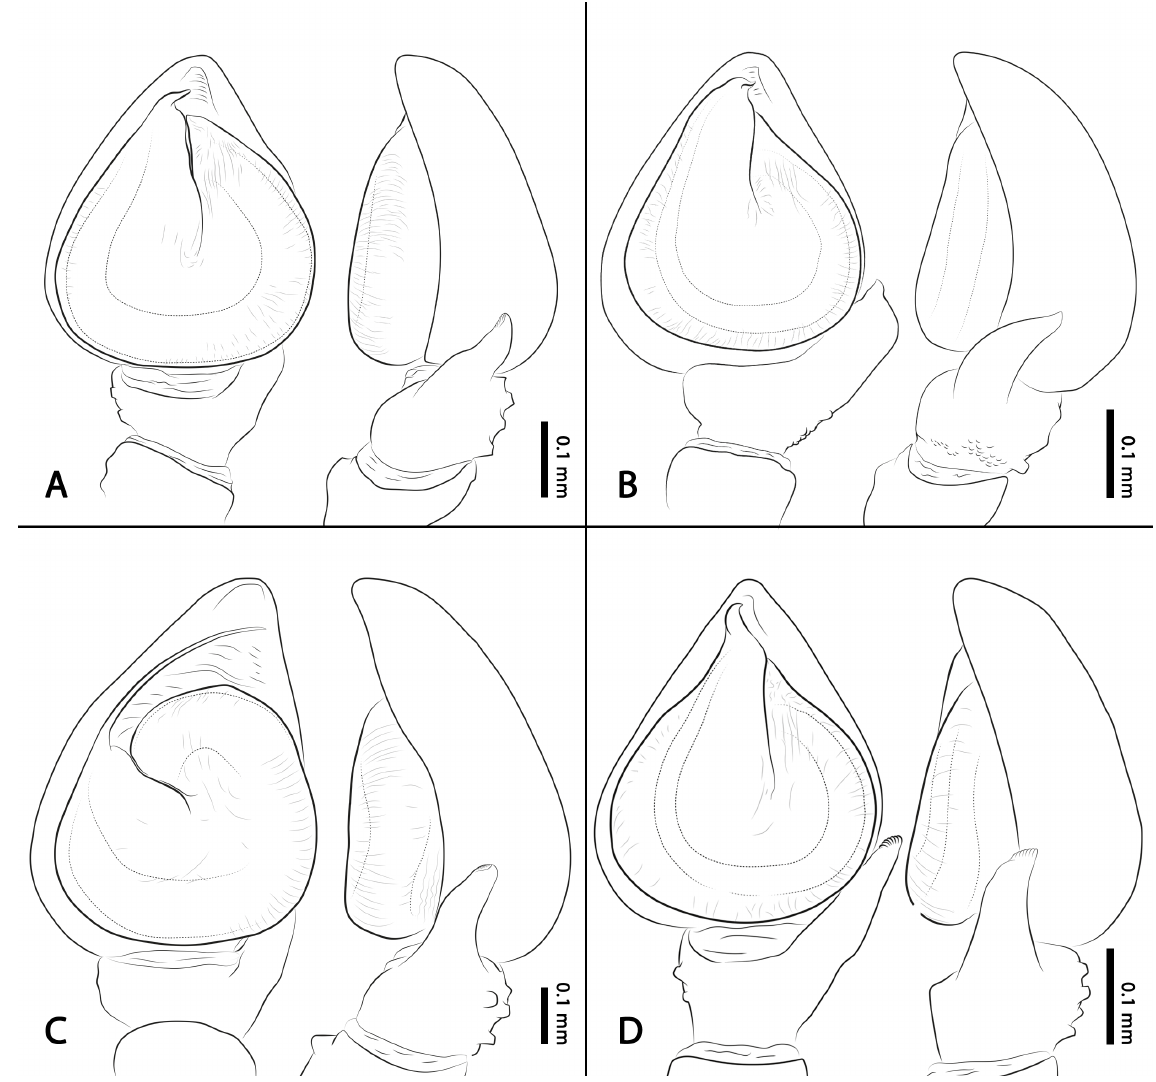
Fig. 20. Illustrations of the left male palp in ventral and retrolateral view. A . Kryptochroma septata Machado & Teixeira gen. et sp. nov., paratype (UFMG 22431). B . K. hilaris Machado & Teixeira gen. et sp. nov. (MPEG 13239). C . K. macrostyla (Mello-Leitão, 1929) gen. et comb. nov. (MZSP 15320). D . K. parahybana (Mello-Leitão, 1929) gen. et comb. nov. (MPEG